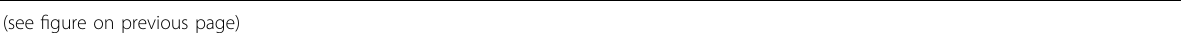
Fig. 5 CUDC-907 and gilteritinib induce complimentary and cooperatively altered activity within the MAPK/ERK and JAK2/STAT5 pathways. A MV4-11 cells were treated with gilteritinib, CUDC-907, both, or neither for 4, 8, 12, or 24 h. Western blots were generated utilizing whole-cell lysates, with representative blots shown, and densitometry displayed below each blot. Densitometry was assessed via comparison to vehicle control and normalized to β -actin. B A primary FLT3-ITD positive AML patient sample was treated with gilteritinib and/or CUDC-907 for 24 h. Densitometry was assessed via comparison to vehicle control and normalized to β -actin. C , D MOLM-13 and MV4-11 cells were treated using CUDC- 907 either with or without AZD1480, a selective JAK2 inhibitor, for 24 h. Flow cytometry analysis of annexin V/PI stained cells is shown in the upper panels and western blot analyses of phosphorylated STAT5 are shown in the lower panels. *** p < 0.001 compared to single-drug treatments. E MOLM-13, MV4-11, and primary patient sample AML#213 were treated with gilteritinib, CUDC-907, both, or vehicle control for 24 h. Western blotting was performed to analyze expression of members of the Bcl-2 family. Densitometry was measured via comparison to vehicle control and normalized to β -actin. F Mcl-1 overexpression and red fl uorescent protein (RFP) control MV4-11 cells were generated using lentivirus particles as described in the “ Methods ” section. Whole-cell lysates were subjected to western blotting to con fi rm overexpression (upper panel). The cells were then treated with vehicle control, gilteritinib, CUDC-907, or in combination for 24 h, and then annexin V/PI staining and fl ow cytometry analysis were performed (lower panel). *** p < 0.001 compared to RFP under the same drug treatment. G , H shRNA knockdown of Bim, Bak, and Bax, or non- template control (NTC) was performed in MV4-11 cells. Whole-cell lysates were subjected to western blotting (upper panels). Cells were treated with vehicle control, gilteritinib, CUDC-907, or in combination for 24 h. Annexin V/PI staining and fl ow cytometry analysis results are shown (lower panels). *** p < 0.001 compared to NTC for the same drug